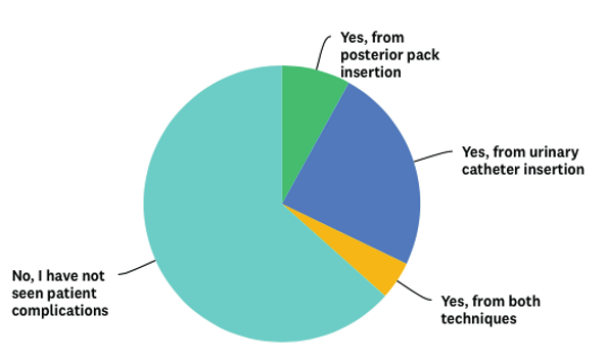
Figure 9. ‘Have you seen complications from either technique?’